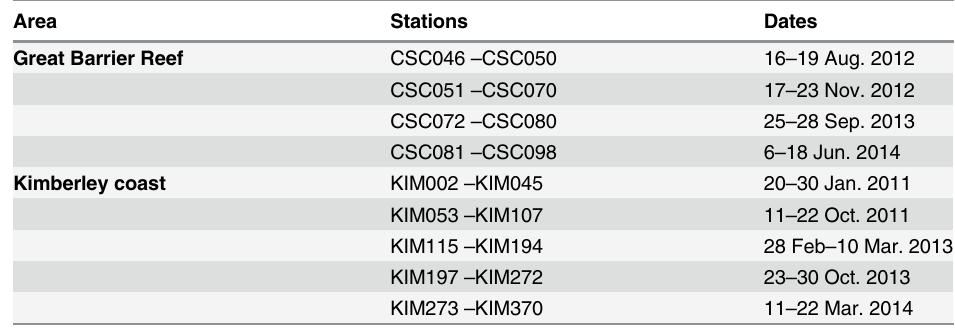
Table 1. Stations occupied on each